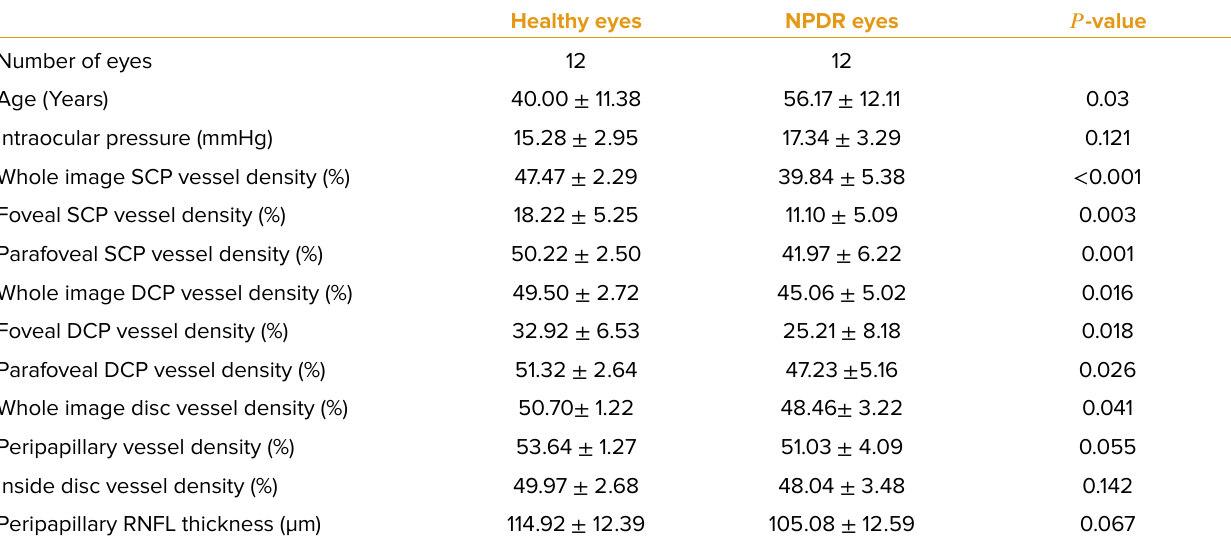
Table 1. Baseline characteristics in the two groups.